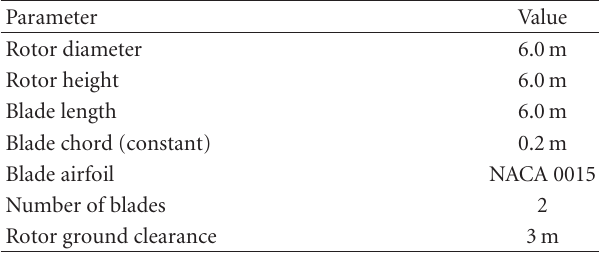
Figure 4: Power coe ffi cient versus TSR for the 7kW VAWT with fixed and variable pitch blades. Table 1: Characteristics of the rotor used in the